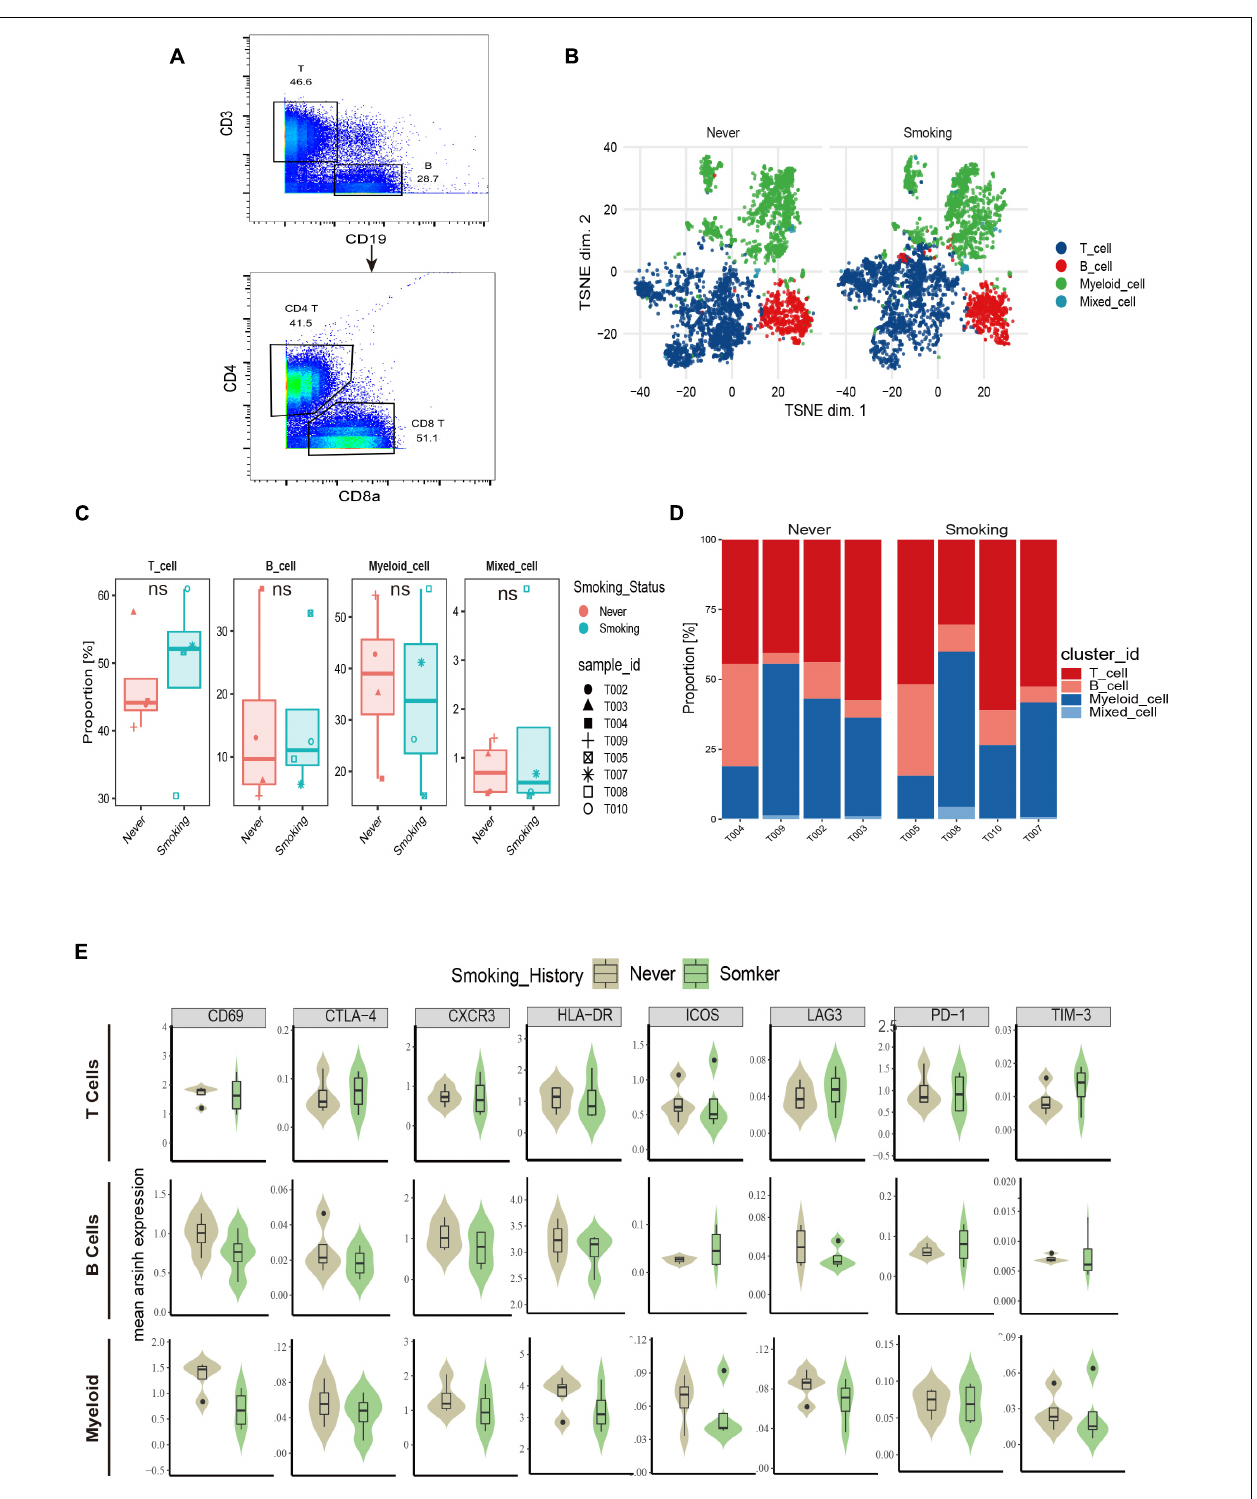
FIGURE 5 | The immune landscape of NSCLC patients sequenced by CyTOF. (A) Schematic diagram of flow gating. CD45 + cells were manually selected and subjected to sequential gating to identify the Immune cell subsets with CyTOF. (B) t-SNE plot showing the overall distribution difference of immune clusters between previous or current smokers and non-smokers. (C) Box plot comparing the relative abundance of each immune cluster between different smoking status groups. Box plot center and box correspond to median and IQR, respectively. Different shapes were used to represent each patient. (D) Bar plot showing the relative abundance of 4 immune cell types in each sample, faceted by smoking status. (E) The expression of surface molecules showed in different immune lineages.